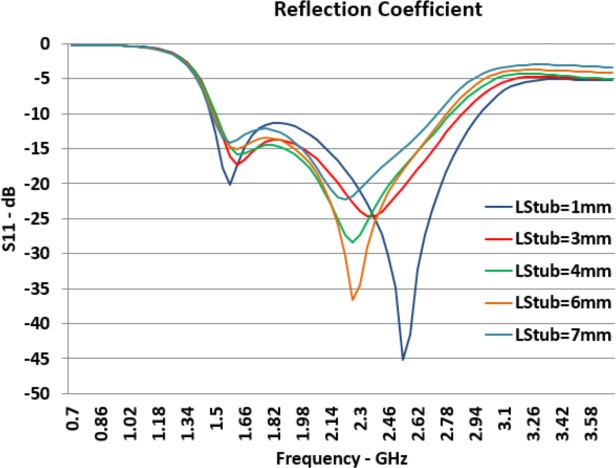
Effect of LStub Changes on Reflection Coefficient (S11).